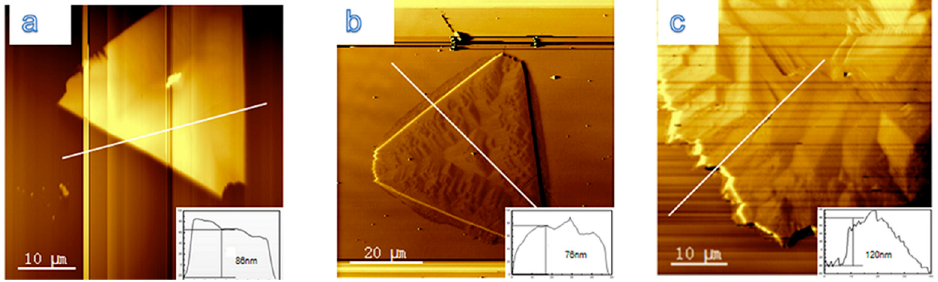
Figure 2. AFM images of ( a ) SnSe 1.14 S 0.92 , ( b ) SnSe 0.93 S 0.94 , and ( c ) SnSe 0.64 S 0.93 . The illustrations are the corresponding height profiles.